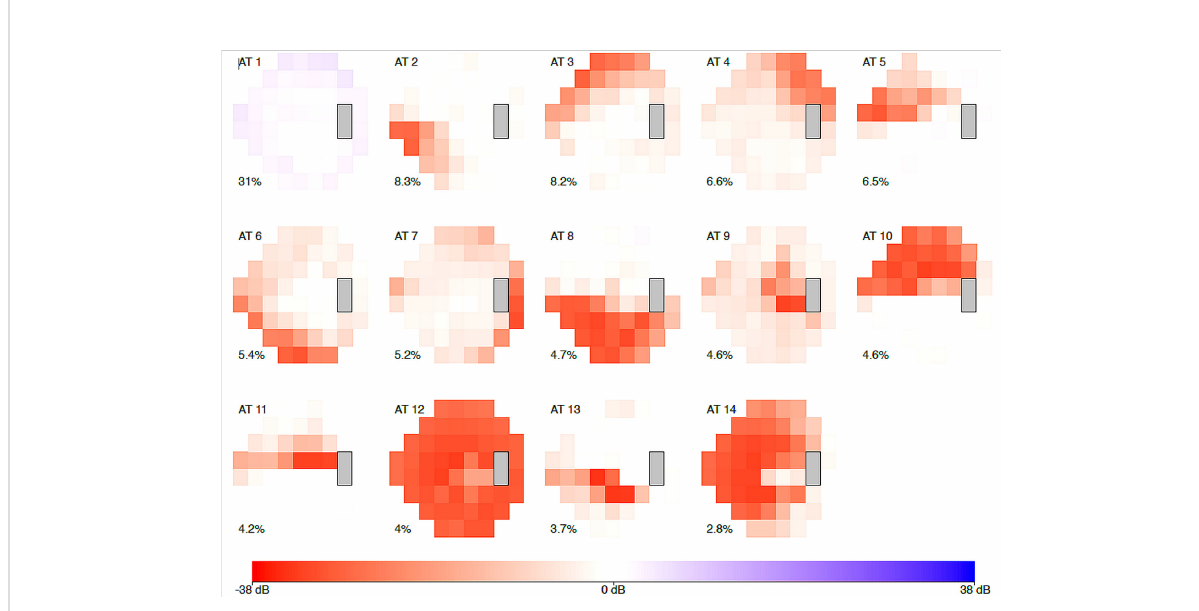
FIGURE 1 The 14 archetypal visual fi eld loss patterns derived from visual fi elds of the 1957 incident primary open-angle glaucoma cases (2581 affected eyes). The integer at the top left of each archetype (AT) denotes the archetype number. The percentage at the bottom left of each archetype indicates this pattern ’ s respective average decomposition weight. The algorithm identi fi ed 14 archetypes: four representing advanced loss patterns, nine of early loss, and one of no visual fi eld loss. African-American patients made up 1.3 percent of the study but had a nearly twofold increased risk of early visual fi eld loss archetypes, and a sixfold higher risk for advanced fi eld loss archetypes, when compared to white patients. [excerpted from